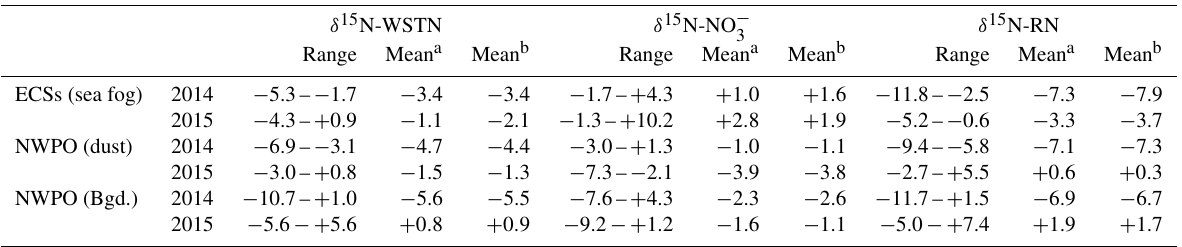
and RN in aerosols. 3